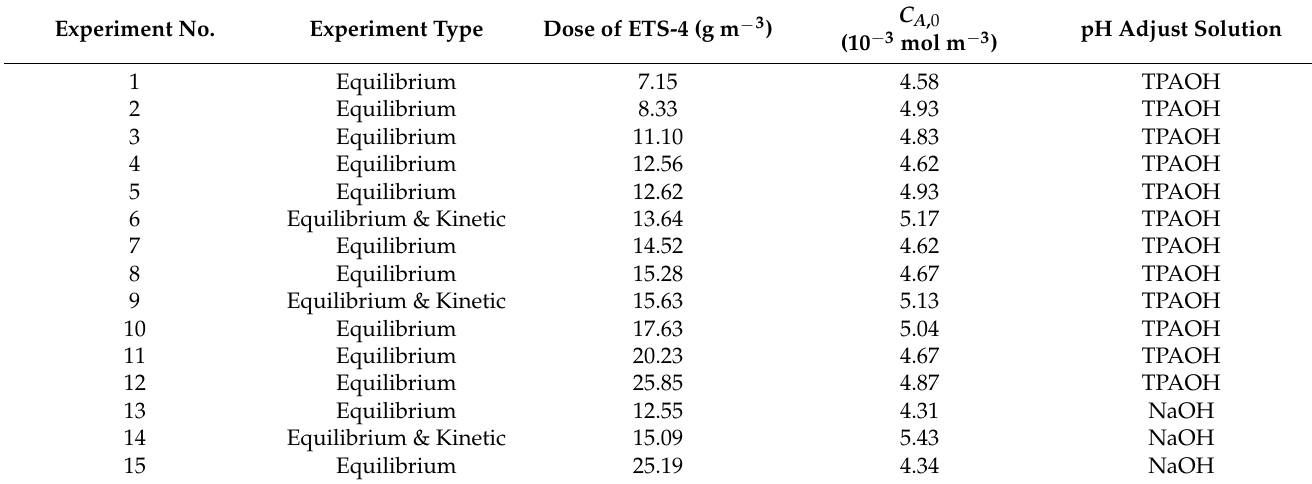
Table 1. Features and initial conditions of each